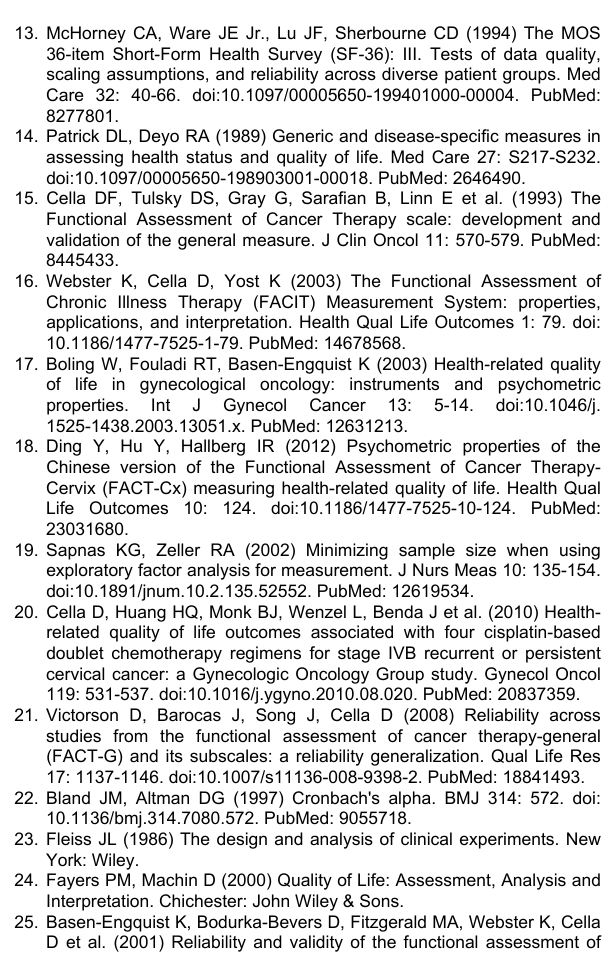
Table S1. Correlation matrix among all individual items of